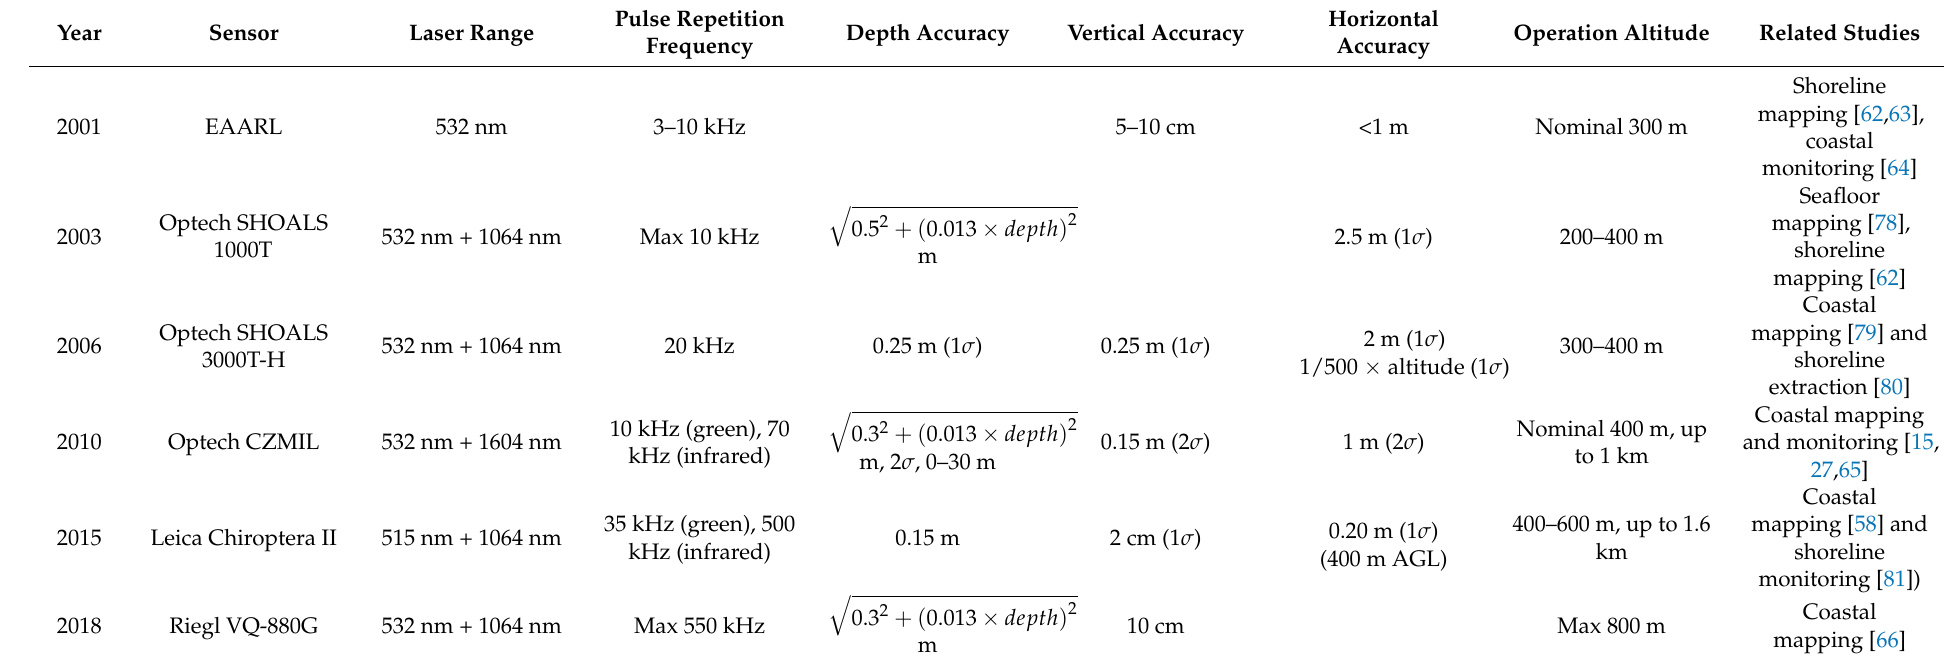
Table 3. A summary of airborne laser bathymetric scanning system (ALB) used in shoreline related